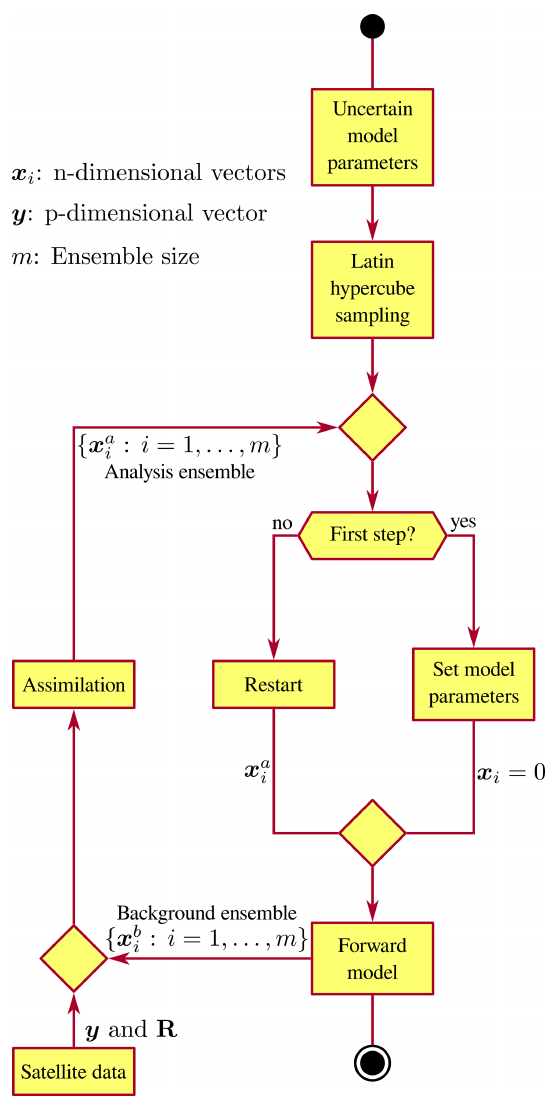
Figure 1. Diagram of the modelling workflow used by FALL3D+PDAF when data assimilation (DA) is enabled. Assim- ilation is performed by means of an ensemble-based DA technique based on a sequential